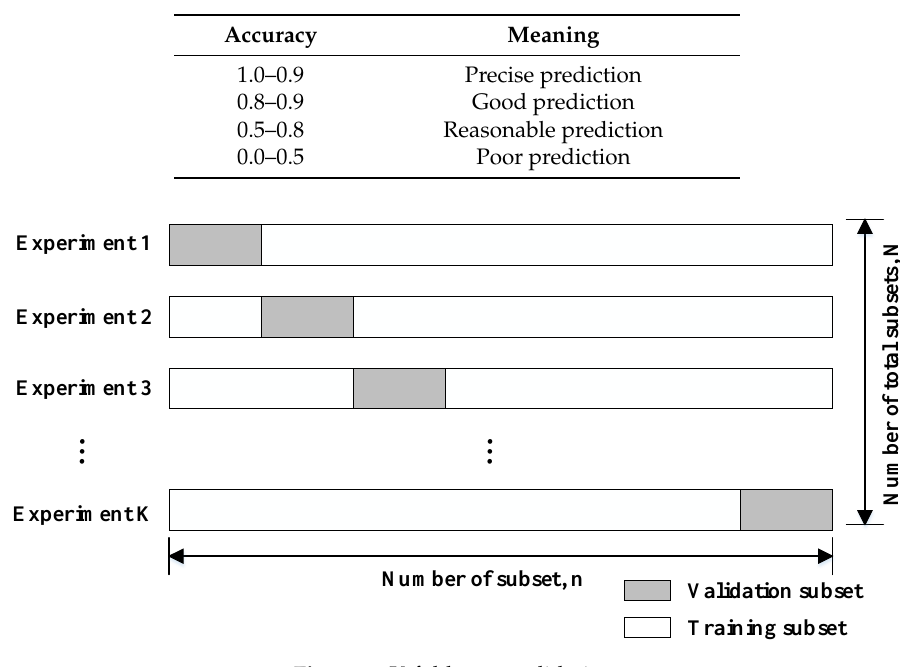
Table 1. Accuracy assessment criteria.